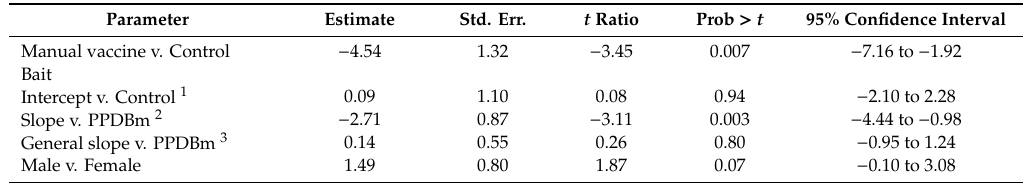
General slope v. PPDBm 3